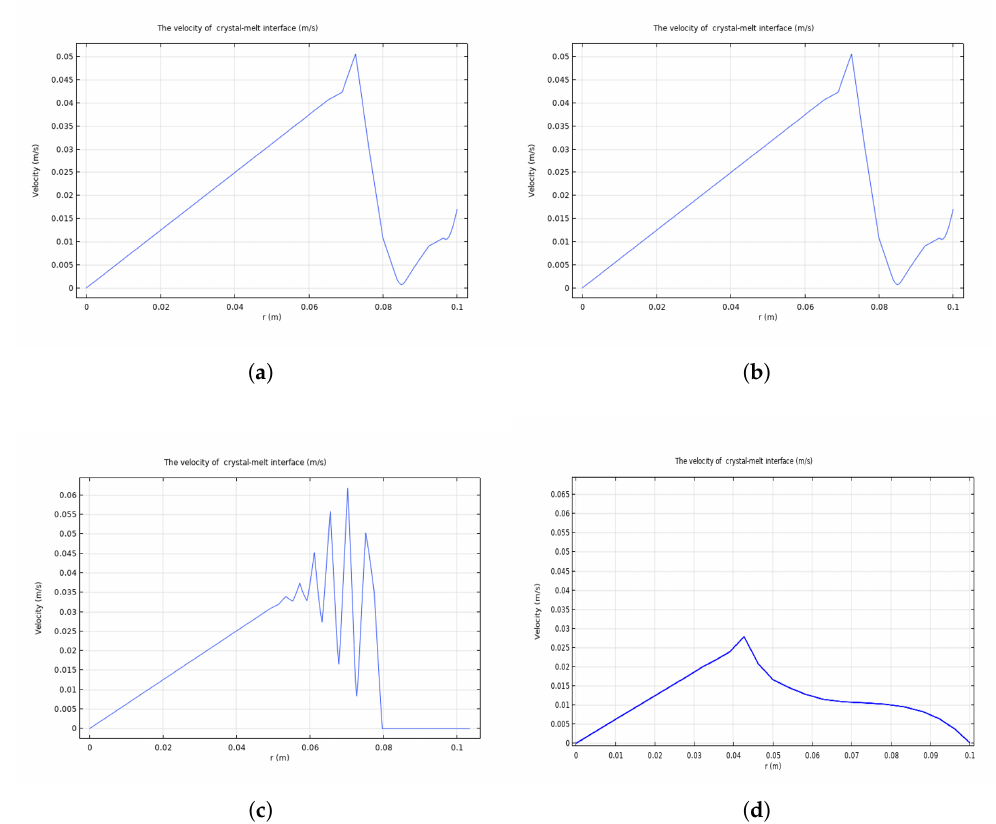
Figure 6. Velocity of the six-inch crystal–melt interface before pulling at equilibrium ( a ) and during pulling at 300 s ( b ) and at 19,000 s ( c ); velocity of the four-inch crystal–melt interface ( d ).